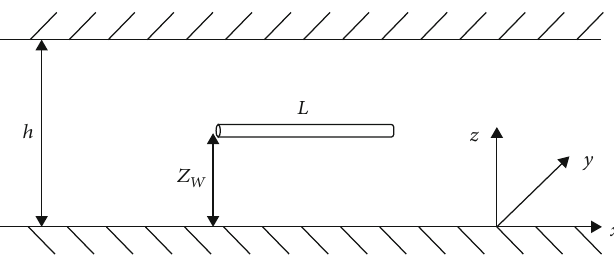
Figure 2: Physical model of a horizontal well in faulted sandstone